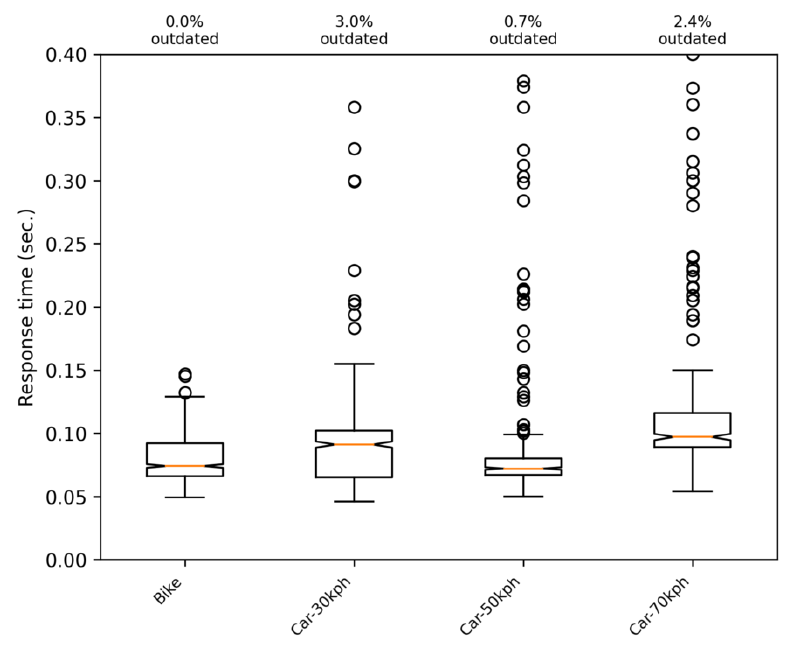
Figure 8. Response times for phones moving at different speeds with the UDP communications version. Same results as Figure 7a with a best suited